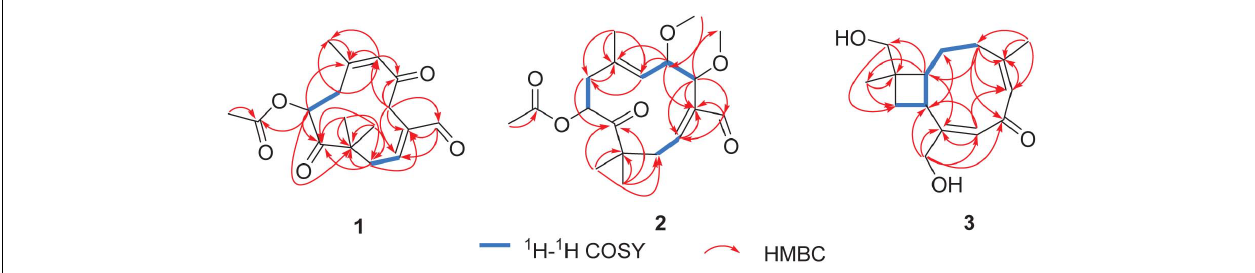
FIGURE 2 | 1 H- 1 H COSY and HMBC correlations of compounds 1–3